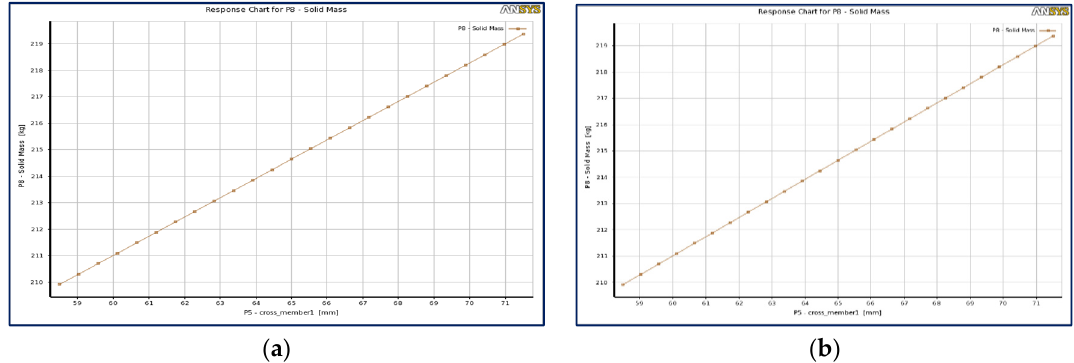
Figure 23. Solid mass vs. cross member 1 ( a ) for CCD scheme, and ( b ) for optimal space filling design. The minimum mass of the chassis is observed for 58.5 mm cross member 3 and cross member 1 dimension 71.5 mm.